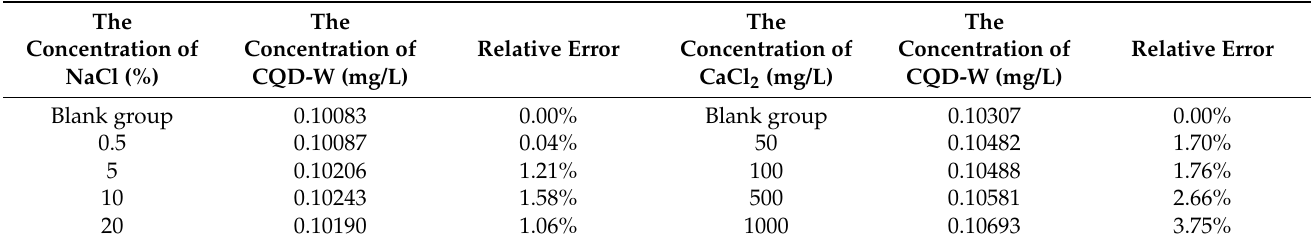
Table 2. Effect of stratigraphic ions on the stability of CQD-W.